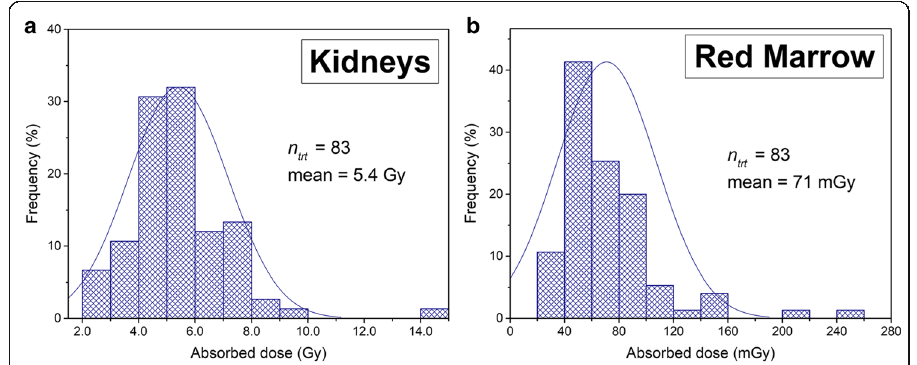
Fig. 7 Histogram of the absorbed dose to the ( a ) kidneys and ( b ) bone marrow for 83 therapy cycles given to 24